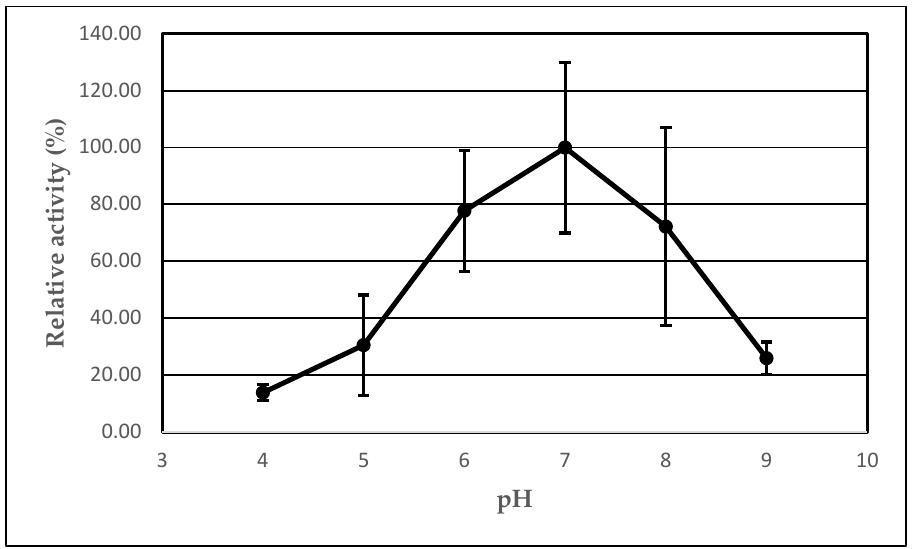
Figure 6. Effect of immobilization on AA-ANL activity under various pH conditions. Reaction mixture: free AA-ANL (5.0 ± 0.2 mg) or AA-ANL immobilized on IB-150A beads, phosphate buffer (100 mM, pH in the range of 4–9), and an emulsion containing equal volumes of peanut oil and gum arabic suspension. The mixture was incubated for 30 min). The error bars represent the standard deviations of the mean.